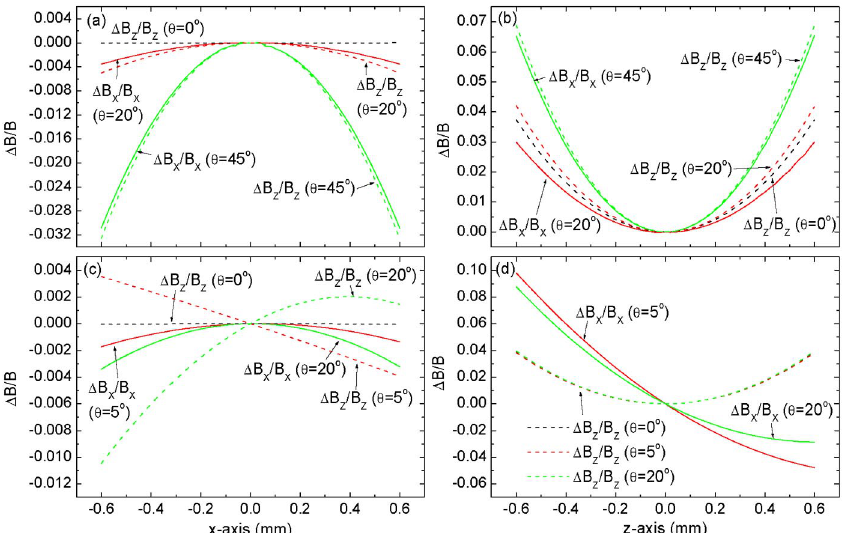
(cid:3) x; z (cid:4) =B (cid:3) 0 ; 0 (cid:4) x x